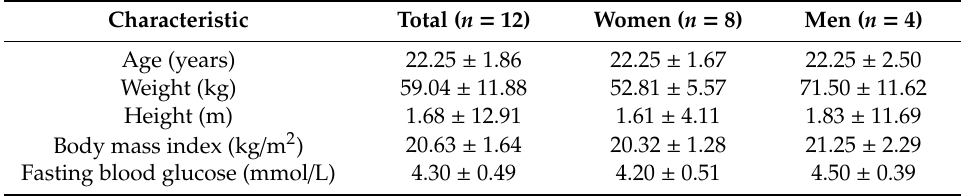
Table 3. Baseline characteristics of the subjects in P1 study